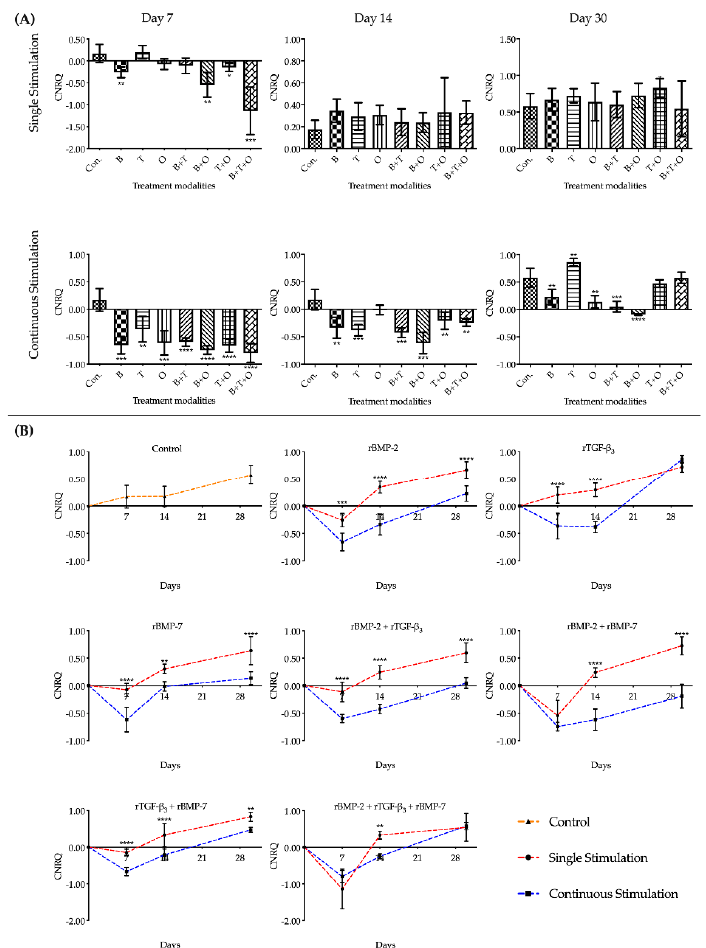
Figure 4. The analyses of the relative expression levels of collagen type I alpha 1 ( Col1 α 1 ). The results were presented as calibrated normalized relative quantity (CNRQ). ( A ) Comparisons between each experimental group under different stimulation modes and the corresponding control group at day 7, 14 and 30 using one-way ANOVA. ( B ) Comparisons between the experimental groups where growth factors were applied continuously and the corresponding 48 h withdrawal groups at day 7, 14 and 30 using two-way ANOVA. Con. = control group, B= rBMP-2 treated group, T = rTGF- β 3 treated group, O = rBMP-7 treated group, B + T = rBMP-2 + rTGF- β 3 treated group, B + O = rBMP-2 + rBMP-7 treated group, T + O = rTGF- β 3 + rBMP-7 treated group, B + T + O = rBMP-2 + rTGF- β 3 + rBMP-7 treated group. Number of replicates ( n ) = 6. We defined p < 0.05 as a statistically significant difference. * p < 0.05, ** p < 0.01, *** p < 0.001, **** p < 0.0001. In ( A ) statistical significance is expressed between each group and the control group (normal medium), while in ( B ) it is expressed in each time point between continuous stimulation and single stimulation. The baseline 0 represents fresh non-cultured muscle tissue which was the normalization factor.